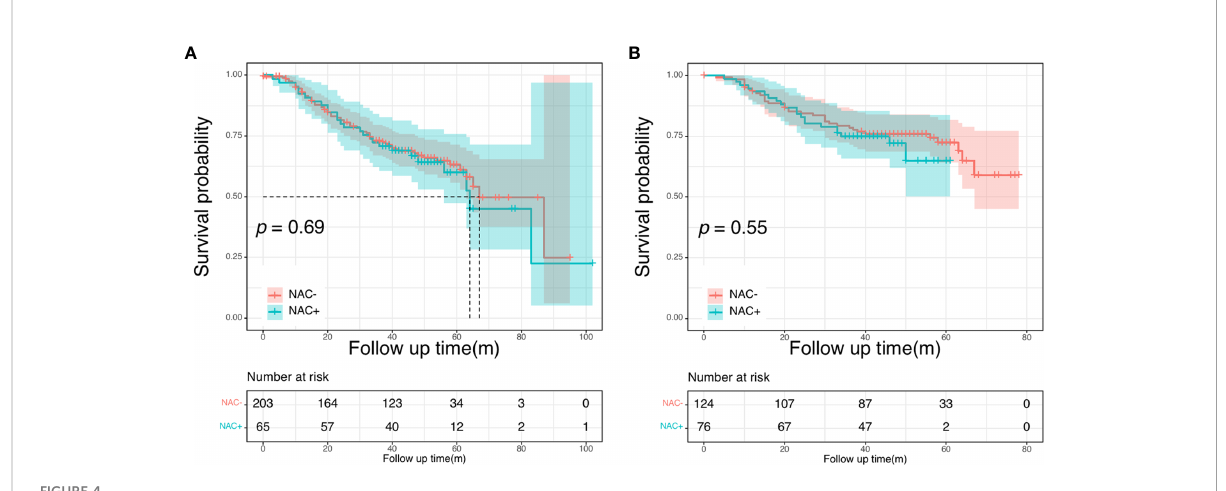
FIGURE 4 Overall survival curves in the NCC cohort: in the entire cohort (A) ; in the propensity score-matched cohort (B) .